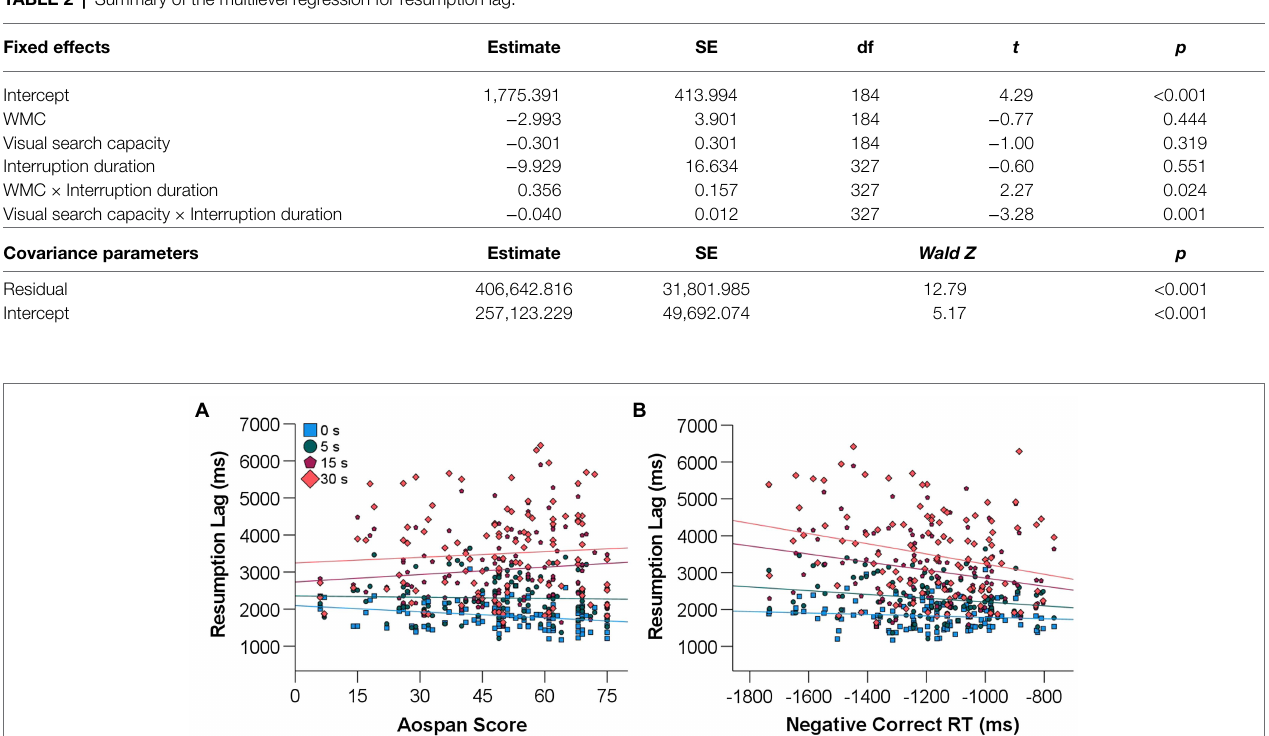
TABLE 2 | Summary of the multilevel regression for resumption lag.